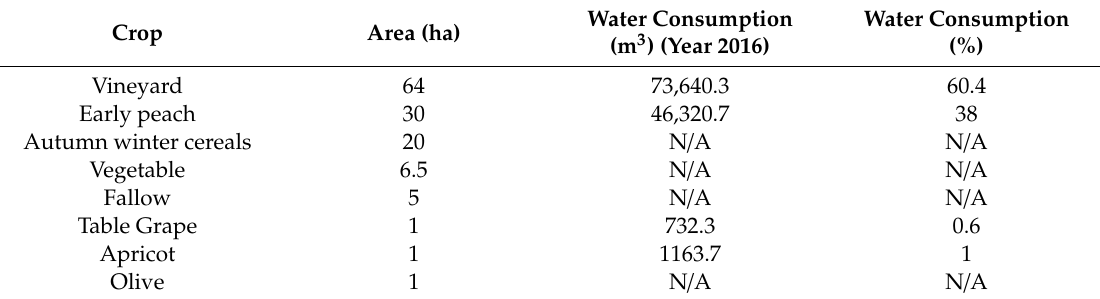
Table 2. Crop water consumption for the year 2016 ( Source: CBC